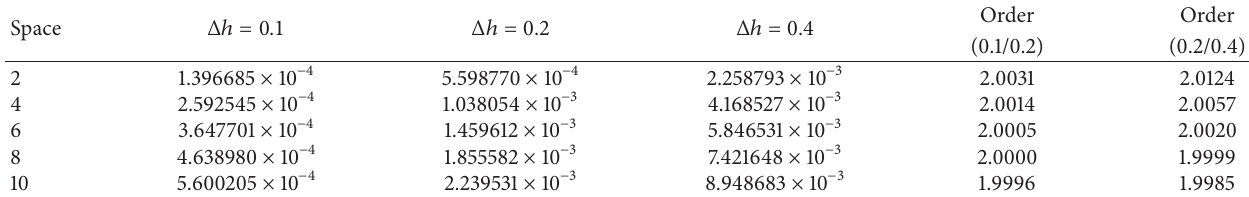
Table 6: The order of convergence in space for 𝐿 2 error norm with 𝑘 = 0.01 and 𝑐 = 0.3 .